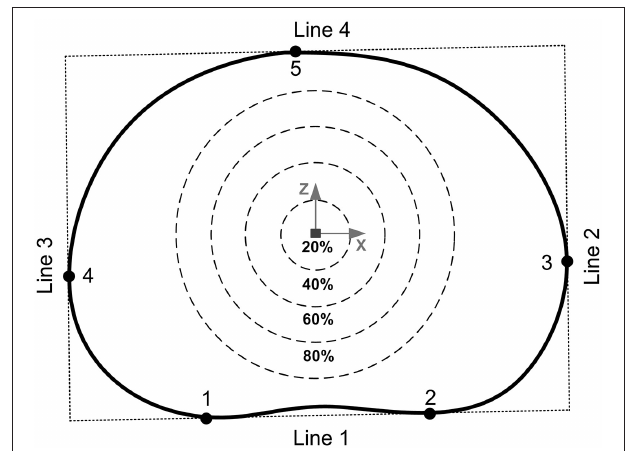
FIGURE 2 | The endplate centroid was located using a method previously developed by Little et al. (2007). Four lines were drawn around the mid-transverse plane of the IVD to create a rectangle: line 1 passed through the two inflections of the posterior annulus boundary (points 1 and 2), lines 2 and 3 were perpendicular to line 1 and passed through the two most lateral points of the annulus boundary (points 3 and 4), and line 4 was perpendicular to lines 2 and 3 passing through the most anterior point of the annulus boundary (point 5). The geometric center of this rectangle was then used as the endplate centroid. The percentages refer to the distance between the furthest of either the most anterior (point 5) or most posterior (points 1 or 2) locations of the IVD in the mid-transverse